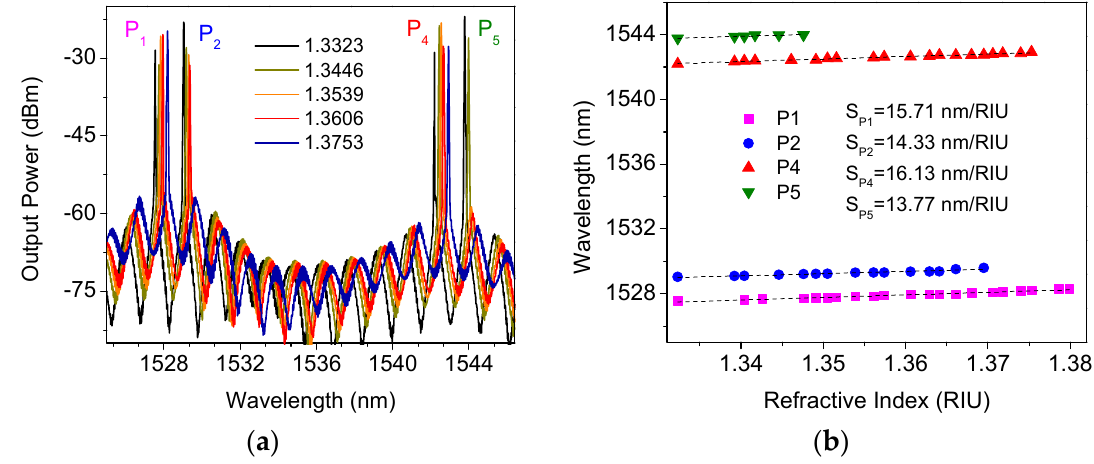
Figure 6. Refractive index response: ( a ) Laser emission response for refractive index ranging from 1.3323 to 1.3757 RIU; ( b ) Refractive index data analysis for lasing modes observed.